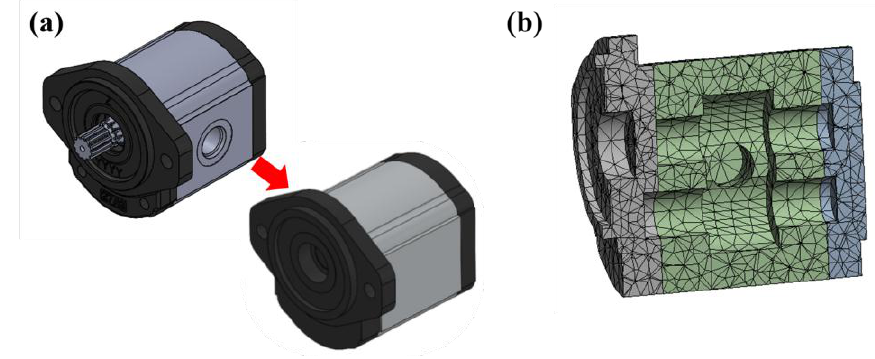
Figure 14. ( a ) Simplification of the geometry of the reference pump and ( b ) FEM mesh. Table 1. FEM ANSYS meshing parameters.